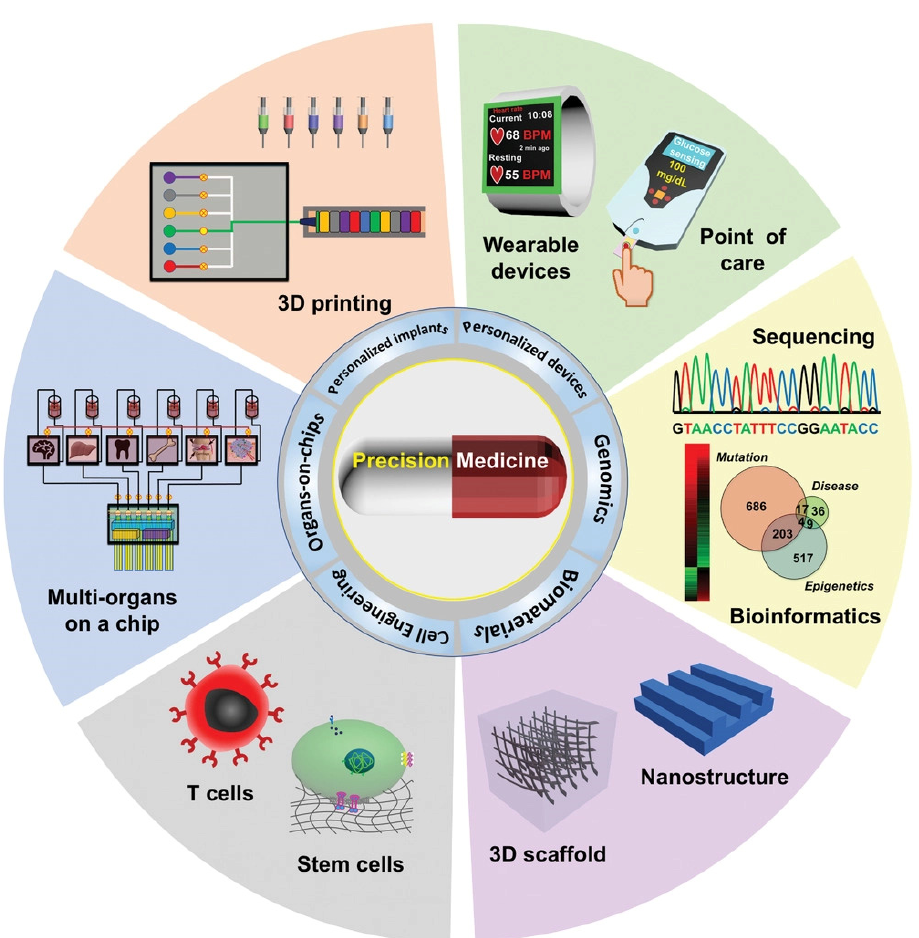
Figure 1. Various approaches to enable precision medicine. Reproduced from [9] under a Creative Commons licence.